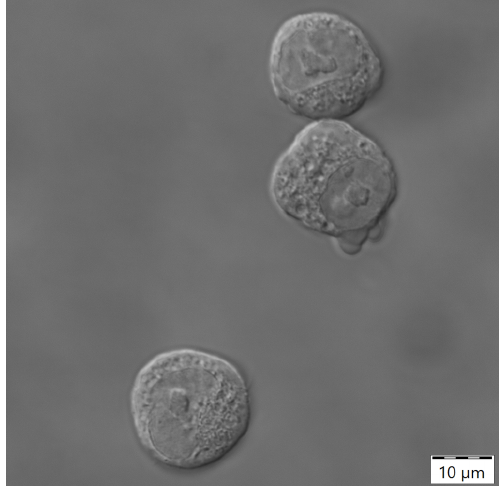
Figure A3. Differential interference microscopy image of HEK293 suspension cells cultivated in a baffled 500mL shake flask (scale bar is